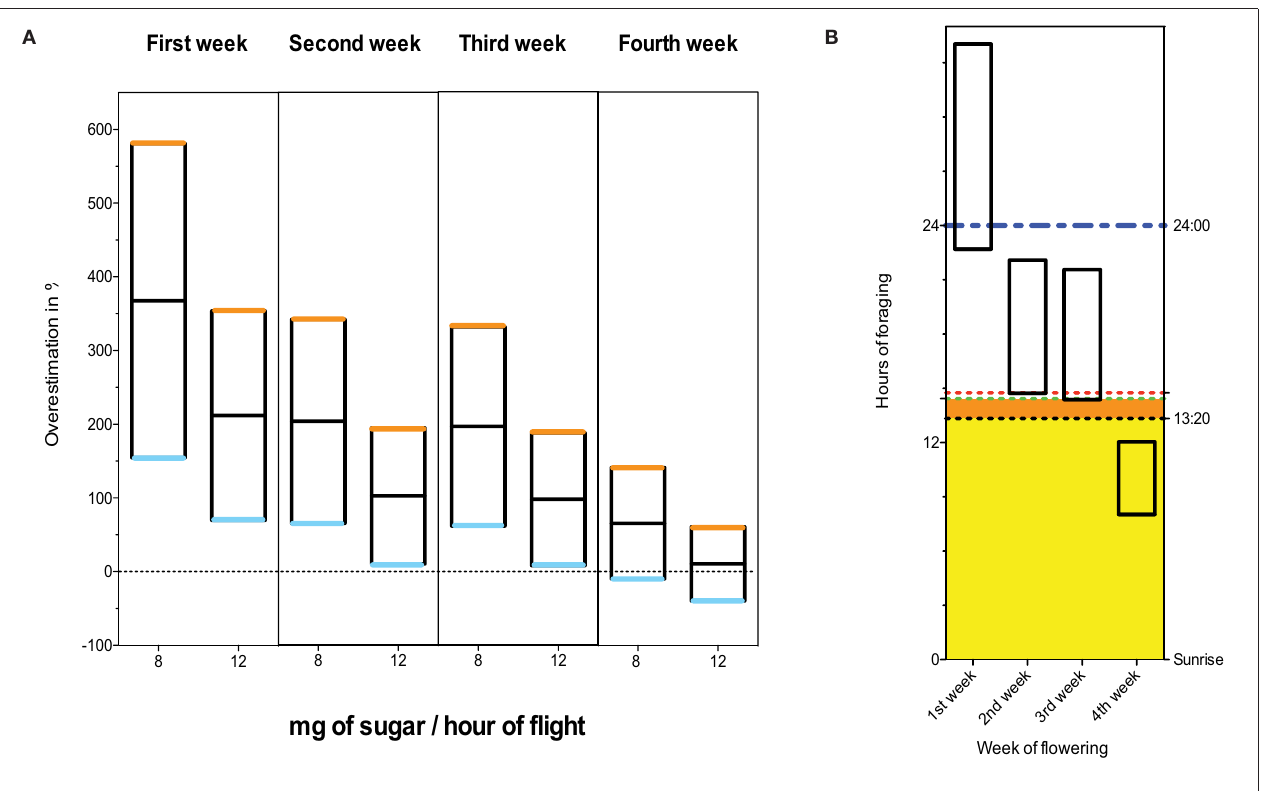
FIGURE 1 | (A) Overestimation of the daily dose of thiamethoxam ingested by foragers. The upper boundary (orange) and lower boundary (blue) correspond to 10.7 and 4h of flight.day − 1 respectively. The middle bar (black) is the mean. The weekly sugar contents are taken from Table 3 in Pierre et al. (1999). All calculations are carried out as in Henry et al. (2012) [based on Rortais et al. (2005) 3 ]. (B) Hours of foraging per day needed to reach 1.34ng.bee − 1 of thiamethoxam. Weekly nectar sugar contents are taken from Table 3 in Pierre et al. (1999). The upper and lower boundaries